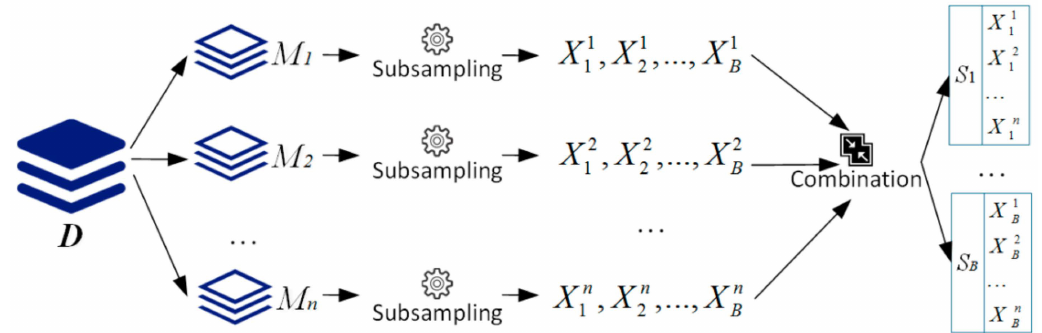
Figure 2. Subsampling-based data partitioning (SubDP)